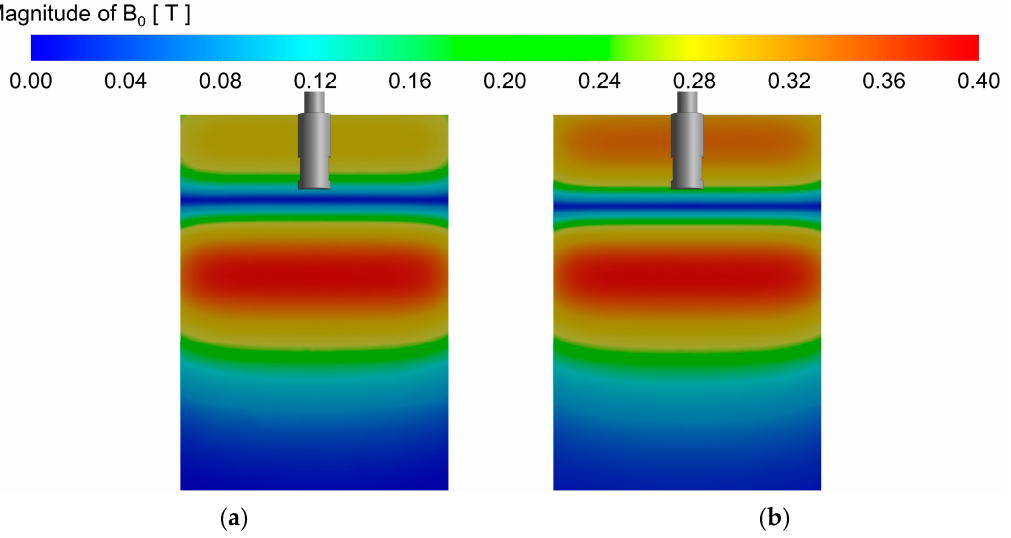
Figure 2. Magnetic flux density distribution under different conditions: ( a ) Mode 2: upper coil cur- rent 0 A, lower coil current 700 A; ( b ) Mode 3: upper coil current 300 A, lower coil current 700 A.